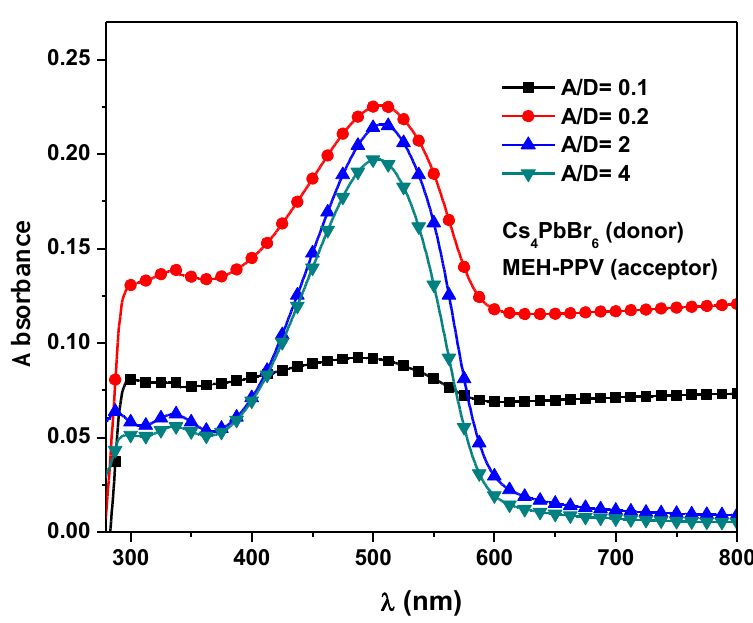
Figure 4. Absorption spectra of the 0-D Cs 4 PbBr 6 / MEH-PPV hybrid thin films.